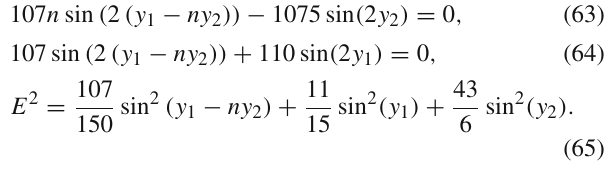
The conditions (59b) and (59c) becomes and the dashed blue lines coincide are found the equilibrium points of the